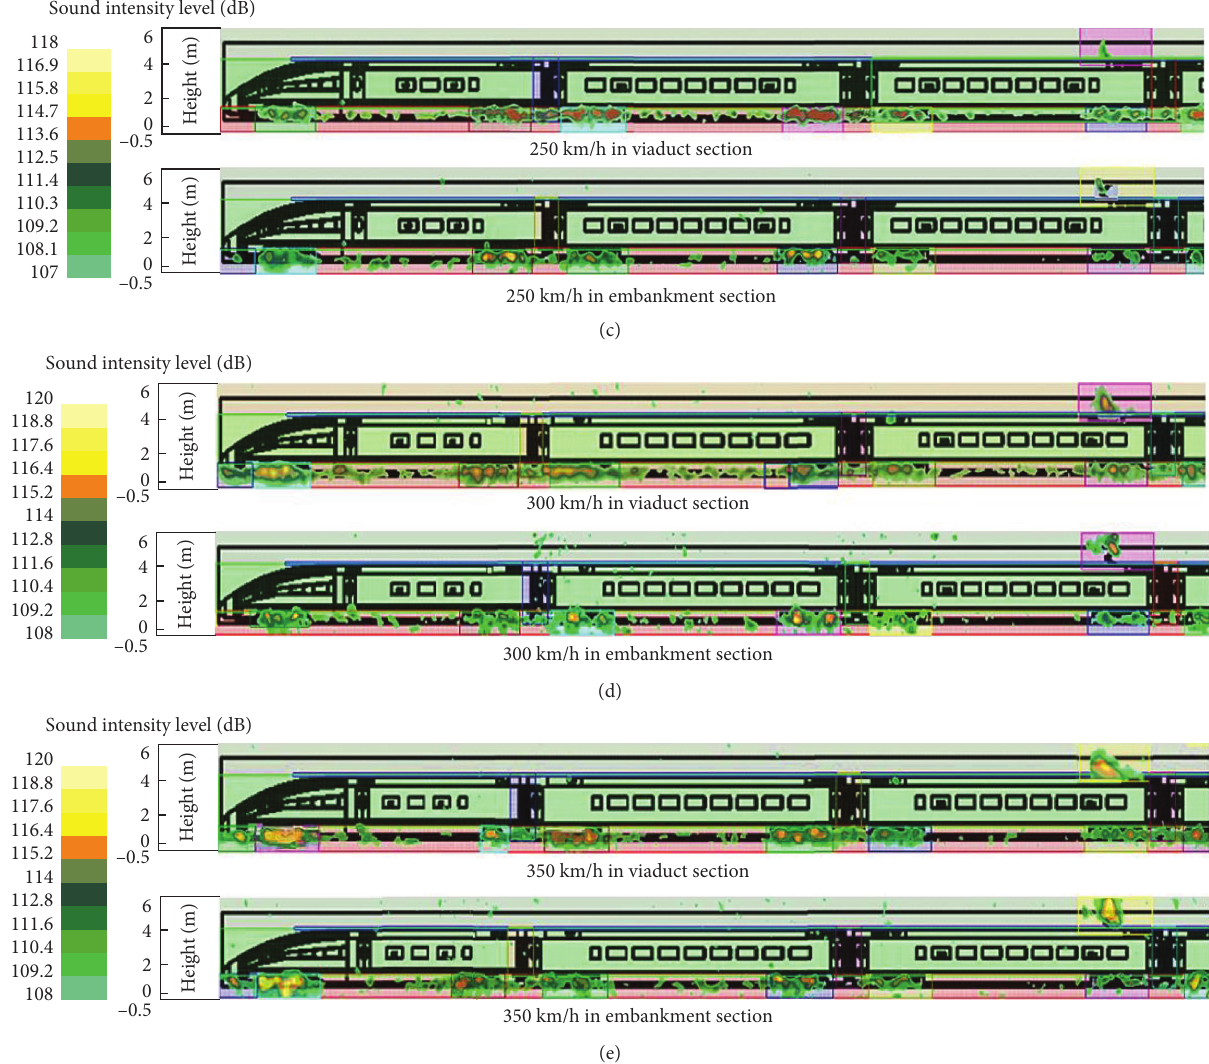
Figure 6: Noise map of contribution at different speeds in different sections. (a) Noise map at 160km/h for both sections. (b) Noise map at 200km/h for both sections. (c) Noise map at 250km/h for both sections. (d) Noise map at 300km/h for both sections. (e) Noise map at 350km/h for both